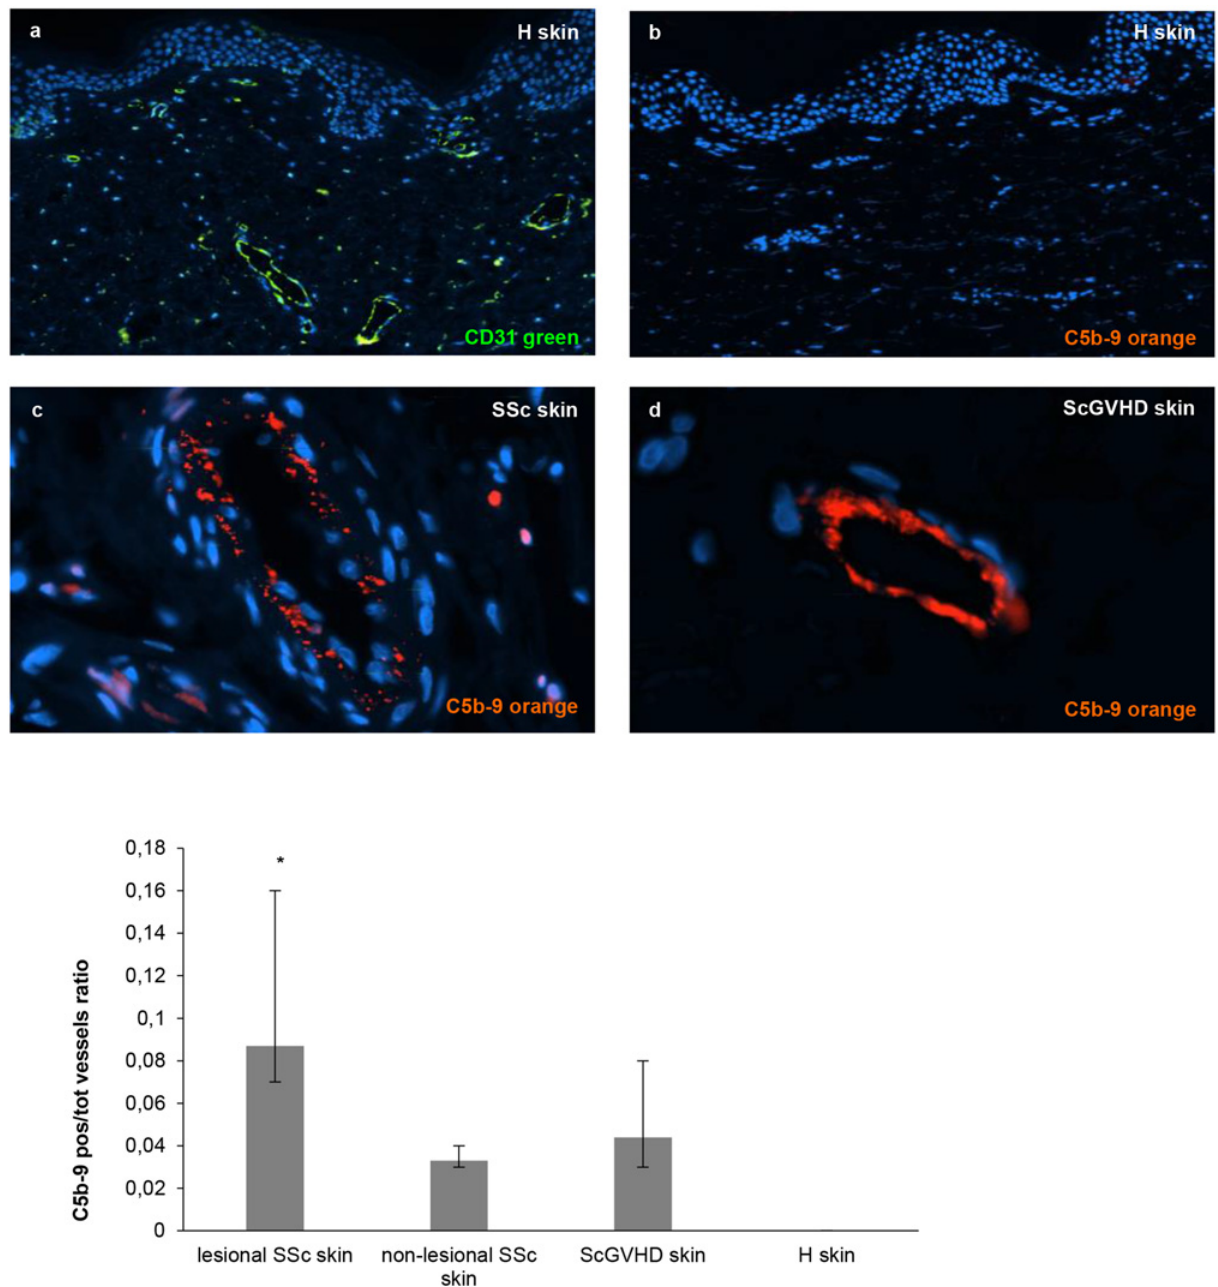
Fig 2. Detection of the complement membrane attack complex (or C5b-9) on skin endothelial cells of SSc patients. Skin biopsies from 8 SSc patients (4 lesional SSc skin and 4 non-lesional SSc skin), 8 healthy subjects and 4 patients with ScGVHD were immunostained for C5b-9 specific antibody (orange). Anti-CD31 antibody (green) was used as marker of endothelial cells and DAPI to stain the nuclei of the cells. Data of the analysed fields ( n = 20 for each slide) are expressed as a ratio between C5b-9 positive vessels and total number of vessels.